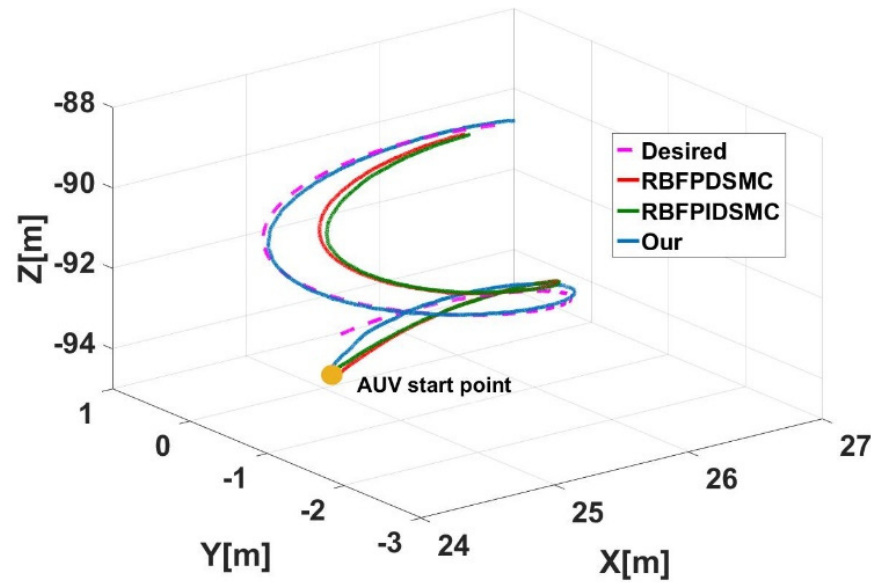
Figure 6. Three − dimensional view of the trajectory. Table 3. Average values of D E